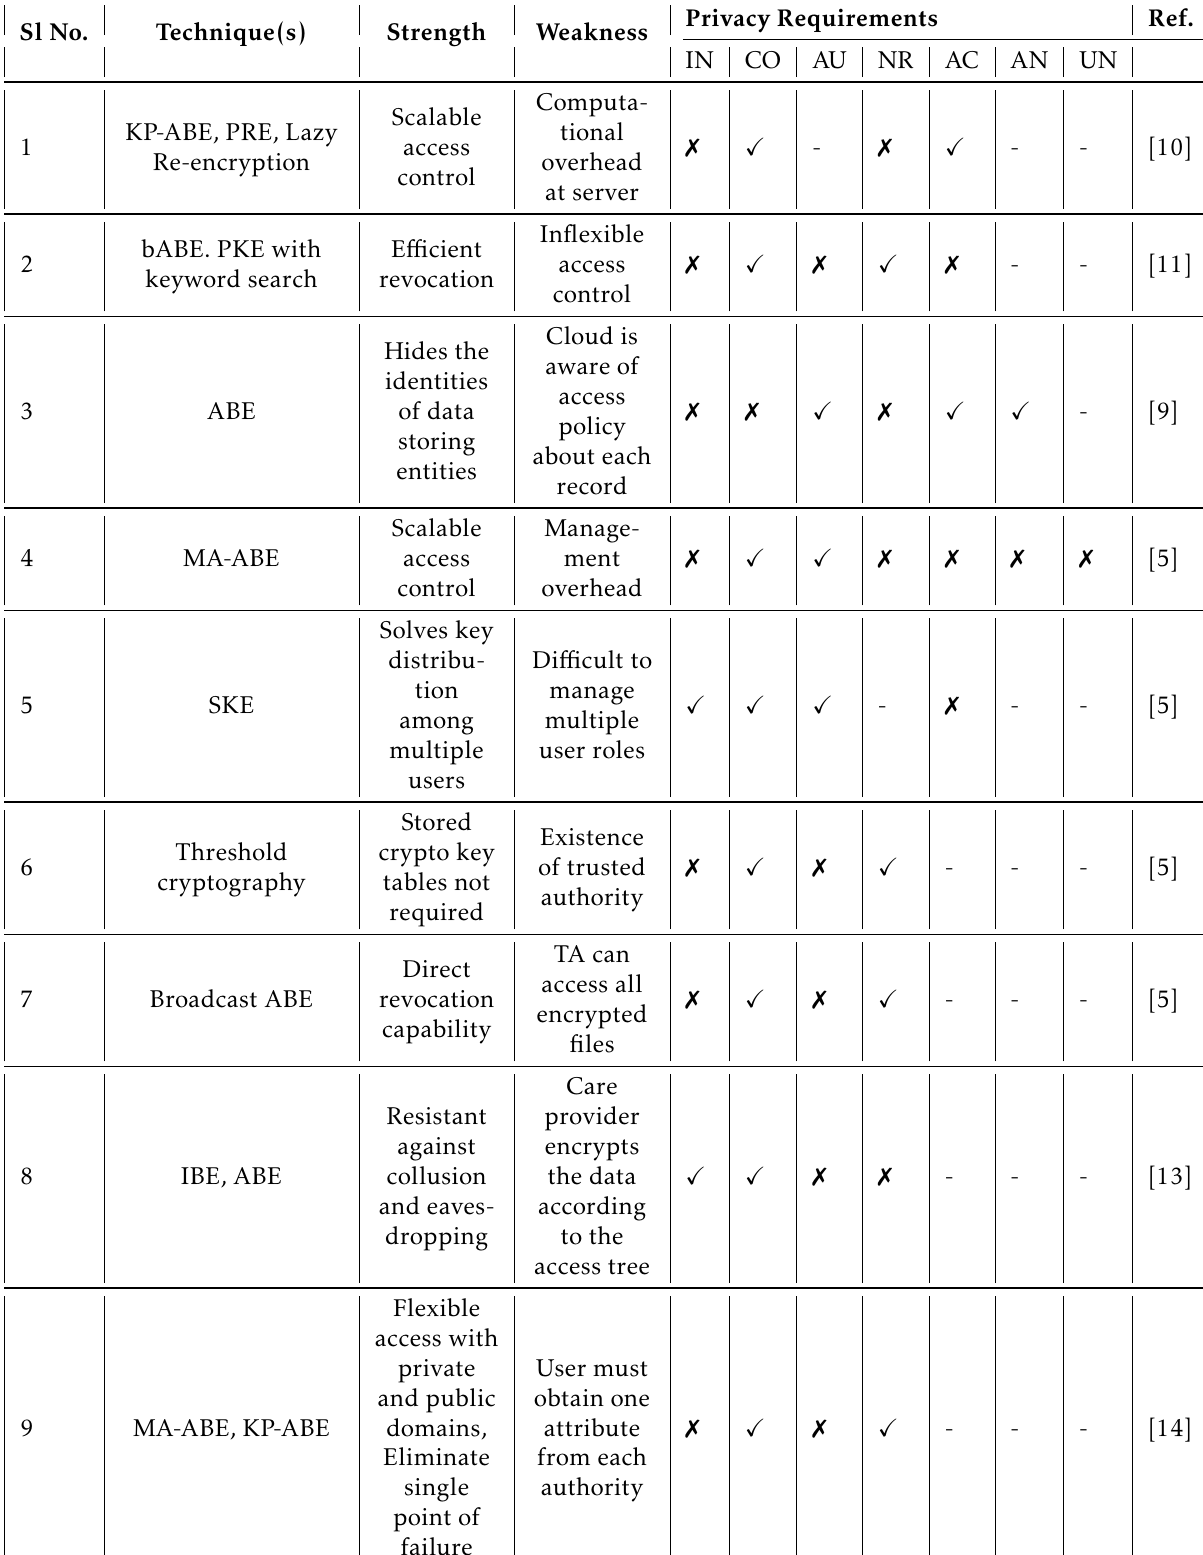
Table 1. Comparison of Privacy Preserving Cryptographic Approaches Sl